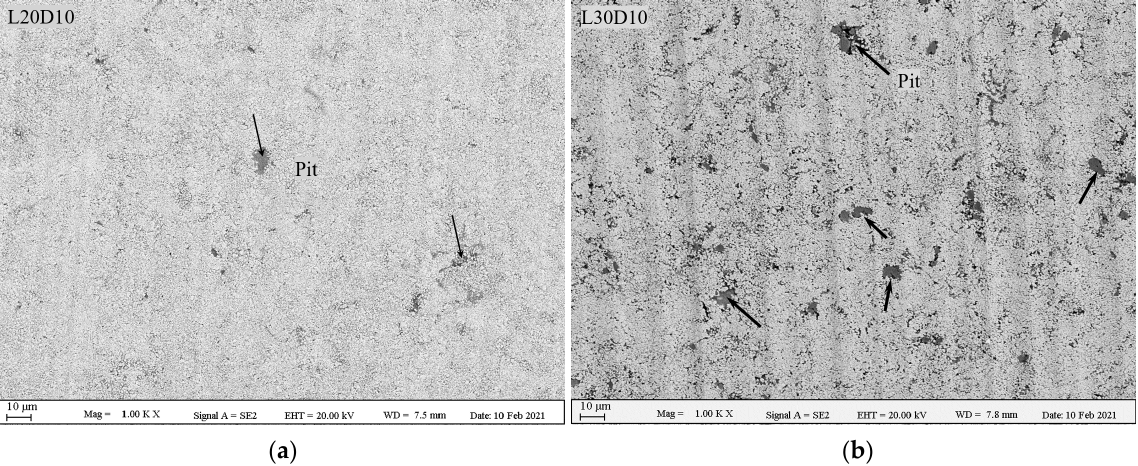
Figure 11. SEM images of wear tracks performed under 20 N ( a ) and 30 N load ( b